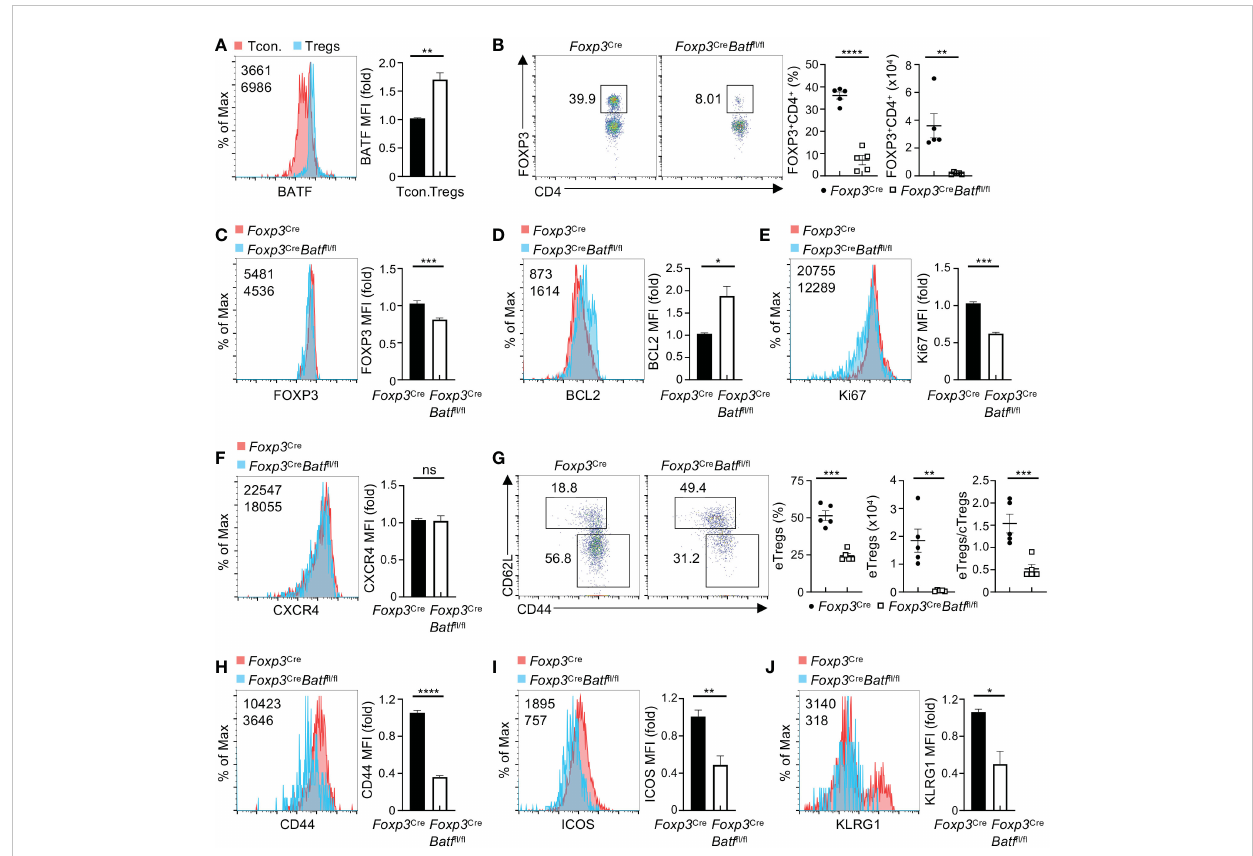
FIGURE 2 BATF de fi ciency compromises BM Treg homeostasis. (A) Flow cytometry analysis (left) of BATF expression in FOXP3 + Tregs and conventional FOXP3 – CD4 + T (Tcon.) cells in the BM. Right, fold changes of BATF MFI in BM Tregs and Tcon. cells. (B) Flow cytometry analysis of FOXP3 + Tregs in the BM from Foxp3 Cre and Foxp3 Cre Batf fl / fl mice. Frequencies (middle) and numbers (right) of BM Tregs ( n = 5 per group). (C-F) Expression of FOXP3 (C) , BCL2 (D) , Ki67 (E) , and CXCR4 (F) in Foxp3 Cre and BATF-de fi cient BM Tregs. Right, fold changes of FOXP3 (C) , BCL2 (D) , Ki67 (E) , and CXCR4 (F) MFI in BM Tregs. (G) Flow cytometry analysis of CD62L and CD44 expression on Foxp3 Cre and BATF-de fi cient BM Tregs. Frequencies (left) and numbers (middle) of BM eTregs and ratios of eTregs to cTregs in the BM (right) ( n = 5 per group). (H-J) Expression of CD44 (H) , ICOS (I) , and KLRG1 (J) on BM Tregs from Foxp3 Cre and Foxp3 Cre Batf fl / fl mice. Right, fold changes of CD44 (H) , ICOS (I) and KLRG1 (J) MFI on BM Tregs. Data are representative of at least three independent experiments (A-J) . Data are the mean ± s.e.m. P values are determined by two-tailed Student ’ s t -test (A-J) . * P < 0.05, ** P < 0.01, *** P < 0.001, and **** P < 0.0001. ns, not signi fi